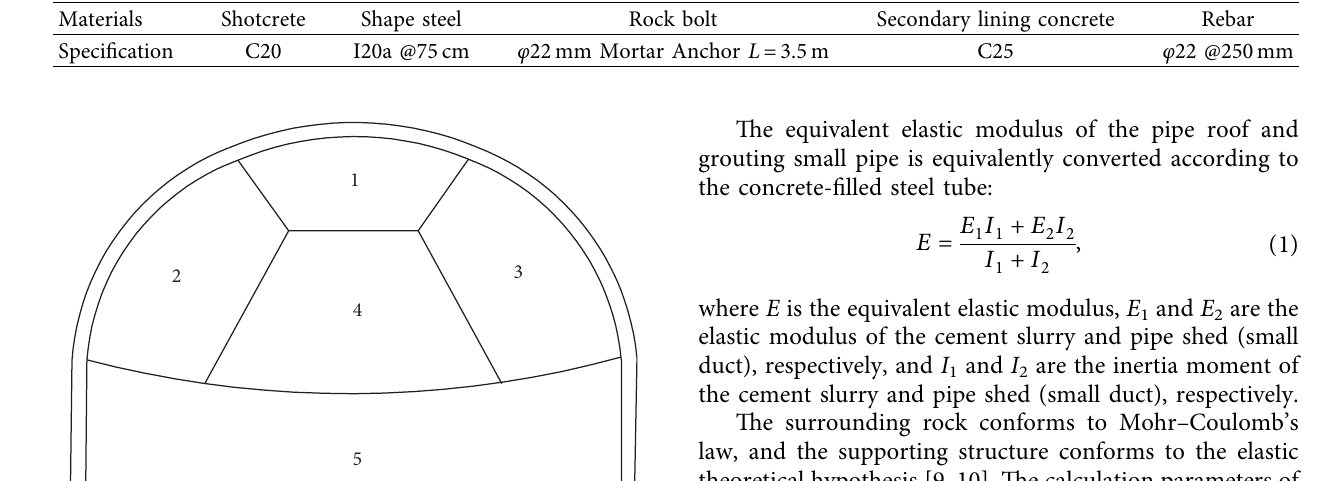
Table 1: Parameters of tunnel support.